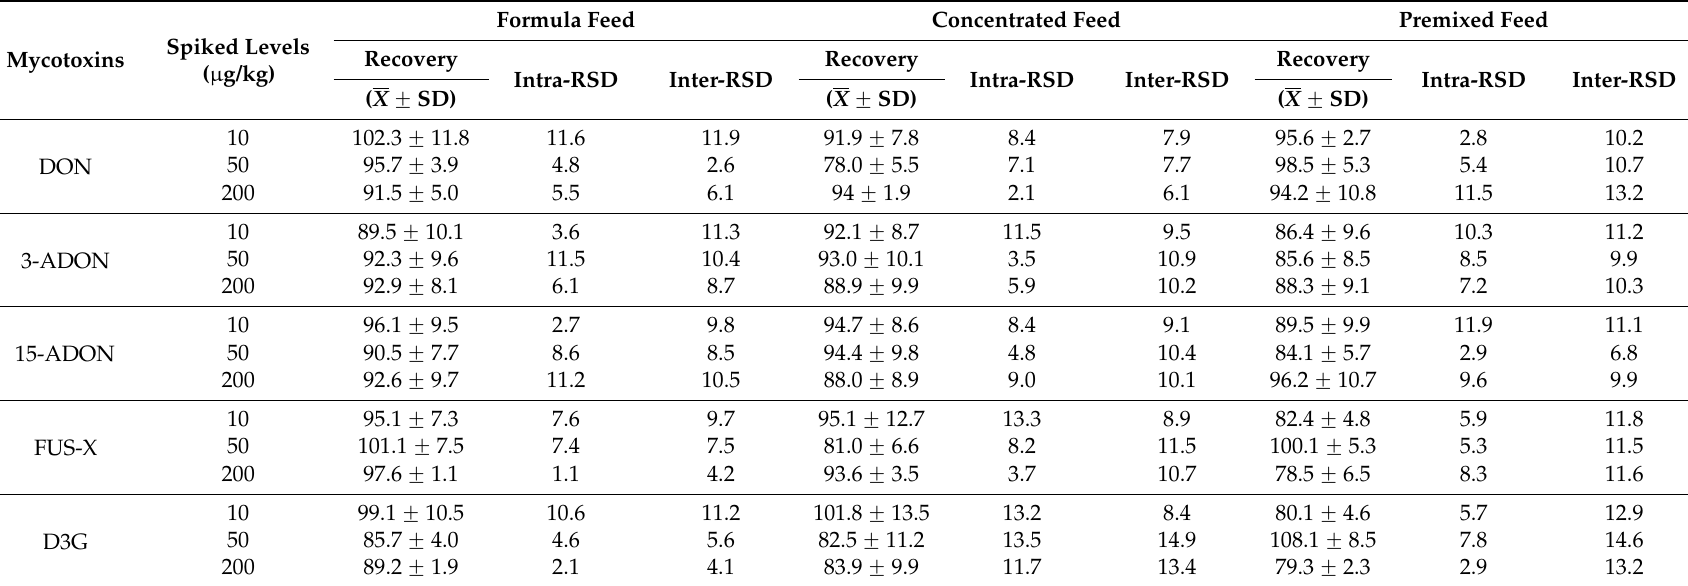
Table 2. Recovery, intra- and inter-day precision of five mycotoxins in various feed products (%, n = 5).